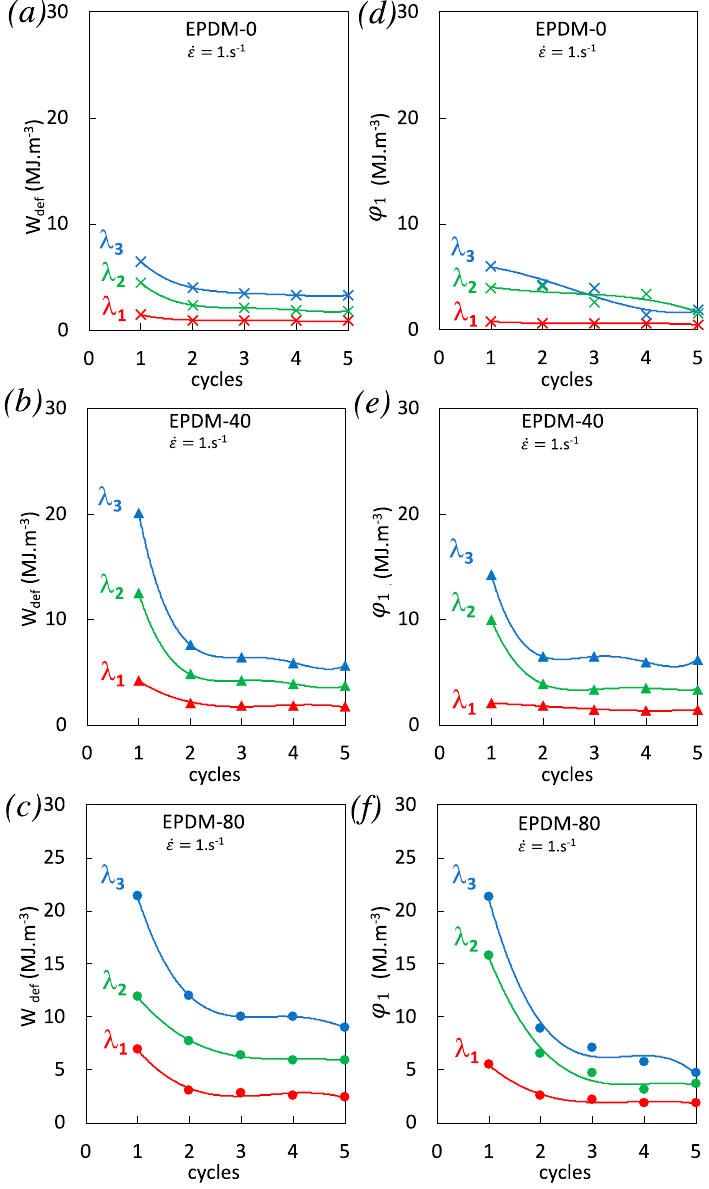
Figure 6. Deformation energy estimated from the area under the stress–strain curve (equation 7) for EPDM-0 ( a ), EPDM-40 ( b ), and EPDM-80 ( c ) and dissipated energy estimated from the integration over each cycle of the heat source (equation 8) for EPDM-0 ( d ), EPDM-40 ( e ), and EPDM-80 ( f ). The energies are calculated for the three different stretching ratios λ 1 = 2 (red data points), λ 2 = 2.9 (green data points), and λ 3 = 3.7 (blue data points) and for the strain rate 1 s ⁻ 1 .